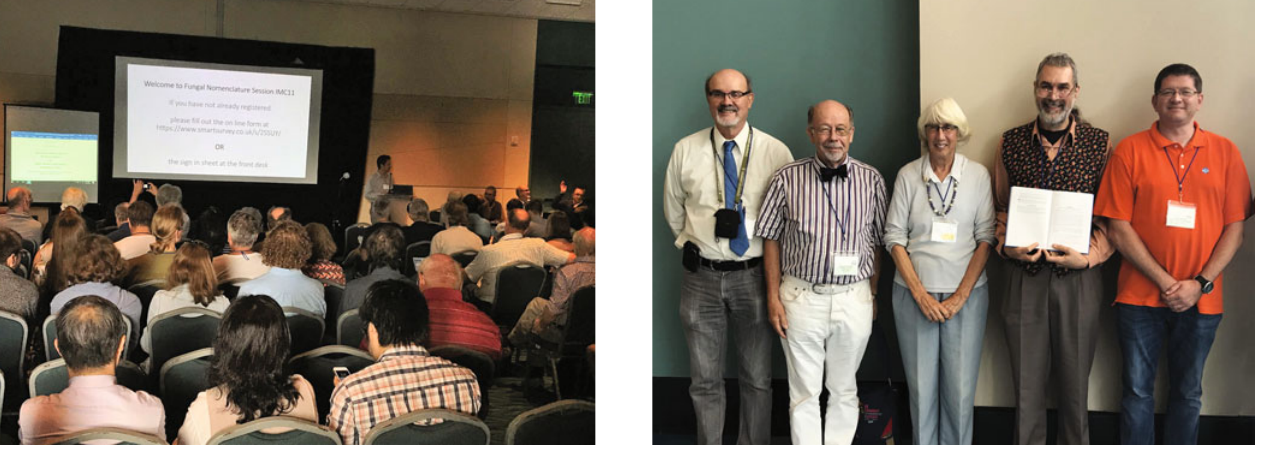
Fig. 1. Pedro Crous, Secretary-General, IMA, opening the Fungal Nomenclature Session, IMC11, Puerto Rico. Nicholas Turland (Rapporteur-général for 2023 International Botanical Congress) on far right, with raised hand. Photo: Wilhelm de Beer.